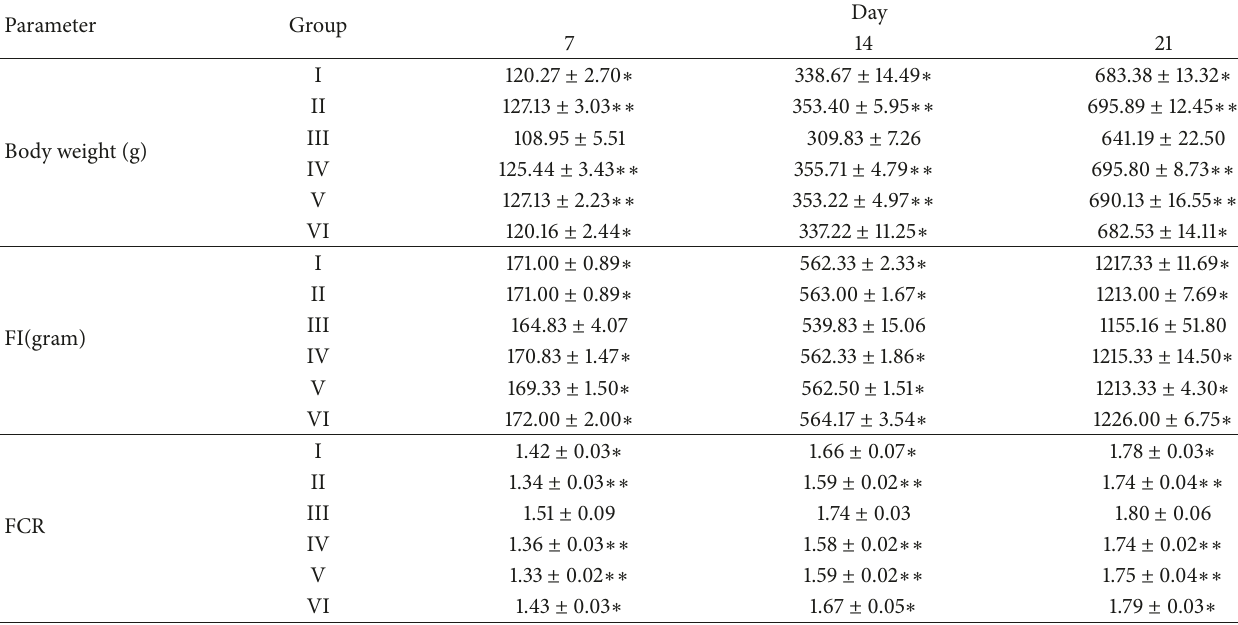
Table 4: Effects of 5% SAP on the body weight, FI, and FCR of broiler chickens fed a diet naturally contaminated with AF at 7, 14, and 21 days of age.